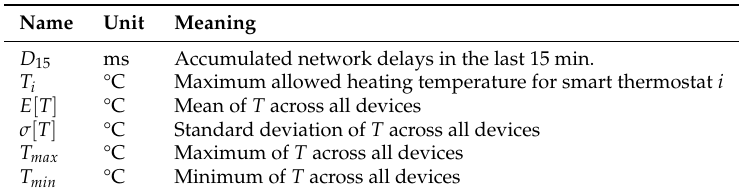
Figure 9. Sequence of snapshots of the simulator during an execution run of the experiment. Initially ( a ), PM 10 levels are comparable in the whole city. After 25 h from the beginning of the experiment ( b ), intense rain enters from north, lowering the PM 10 levels, and covers the whole city in six hours ( c ), thus lowering PM 10 levels everywhere. Rain stops uniformly after 61 h from the beginning of the experiment ( d ), and the overall PM 10 raises with time to the initial level ( e ). Table 4. Metrics for the